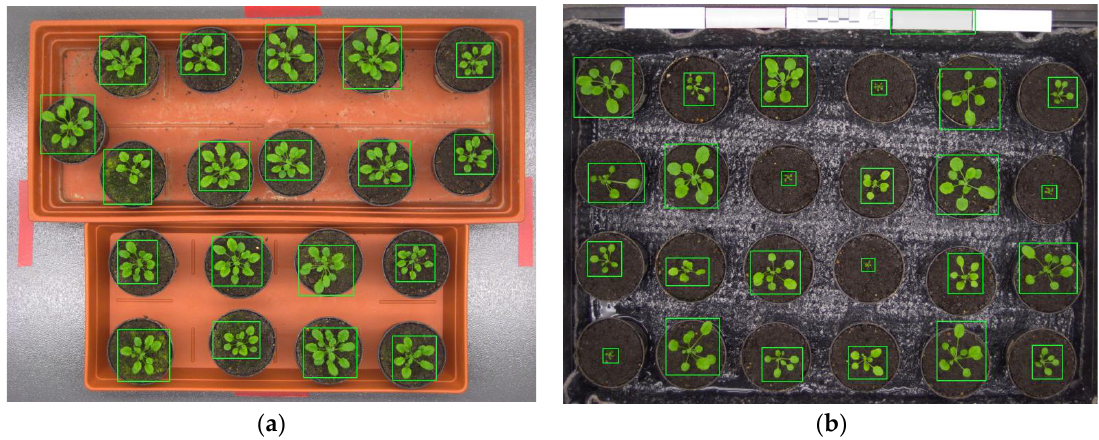
Figure 15. Typical leaf detection results of Arabidopsis thaliana plants: ( a ) Ara2012; ( b ) Ara2013. The evaluation results of the recall, precision, and F1 scores of Ara2012 and Ara2013 using M1 to M6 are shown in Figures 16 and 17, respectively. It should be noted that M1 could not detect leaves in Ara2012; this was caused by the fact that the images of Ara2012 were composed of three distinctively colored objects (leaf, soil, and tray). Thus, bi-level thresholding (M1) failed to separate leaves from the background. Meanwhile, even though Ara2013 was composed of the same three objects, their color was not remarkably different; therefore, bi-level thresholding (M1) could be used to extract the leaves.